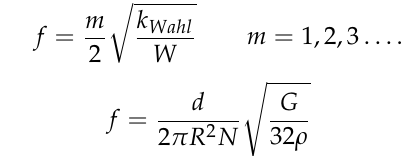
( b ) Figure 2. “Effort de chasse” or transverse flexibility: ( a ) schematic of the test device; ( b ) mounting on a spring bogie compensating the “effort de chasse”. Kobelev [18] also studies another type of anomaly in the behavior of springs such as the transverse vibration of the spring once it enters into oscillations close to resonant fre- quencies. Kobelev [18] found that the fundamental natural frequency of transverse oscil- lations turns to be to zero when the lateral buckling of the spring occurs.